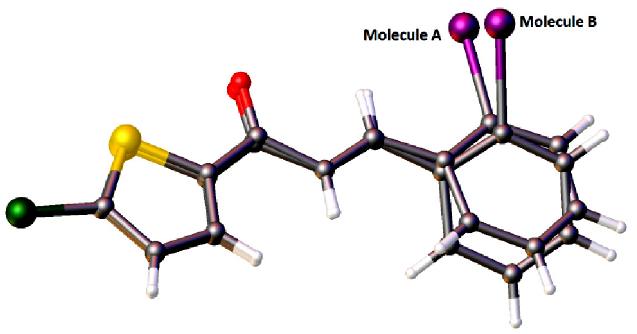
Figure 2. Overlay of all atoms in compound 4a , calculated using the chlorothiophene moiety.